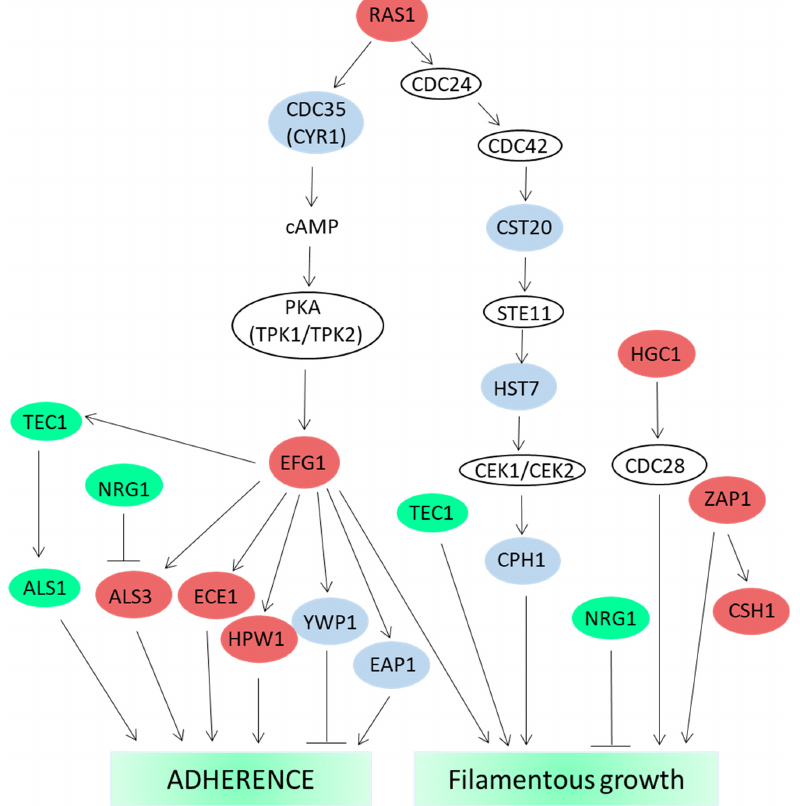
Figure 5. Effect of AEA on Candida albicans gene expression [381]. Genes in red are downregulated by AEA after a 2 h incubation. Genes in green are upregulated by AEA. Genes in light blue are unaffected by AEA. Open circles are genes that have not yet been analyzed. Ultimately, AEA pre- vents the adherence and hyphal extension of Candida albicans . An intercommunication system has been found to exist between the gut microbiota and the endocannabinoid system [285,298,397–402]. The gut microbiota, representing more than 100 trillion microorganisms, including at least 1000 distinct species, lives in symbiosis with the host and assists in controlling the metabolic health of the host by de- grading nutrients that the host is unable to digest and by providing a whole battery of small signaling molecules, metabolites, and nutrients beneficial for the host physiology [298,403]. The gut microbiome differs from individual to individual, and the composition of the microbiota is believed to affect various metabolic disorders, such as obesity, hyper- glycemia, and dyslipidemia, which are risk factors for type 2 diabetes, hepatosteatosis, and arteriosclerosis [404]. Reduced diversity of gut microbiota has been linked with vari- ous pathophysiological conditions, such as depression, schizophrenia, neurological disor- ders, and chronic fatigue [405–409]. Microbiota can affect the endocannabinoid system